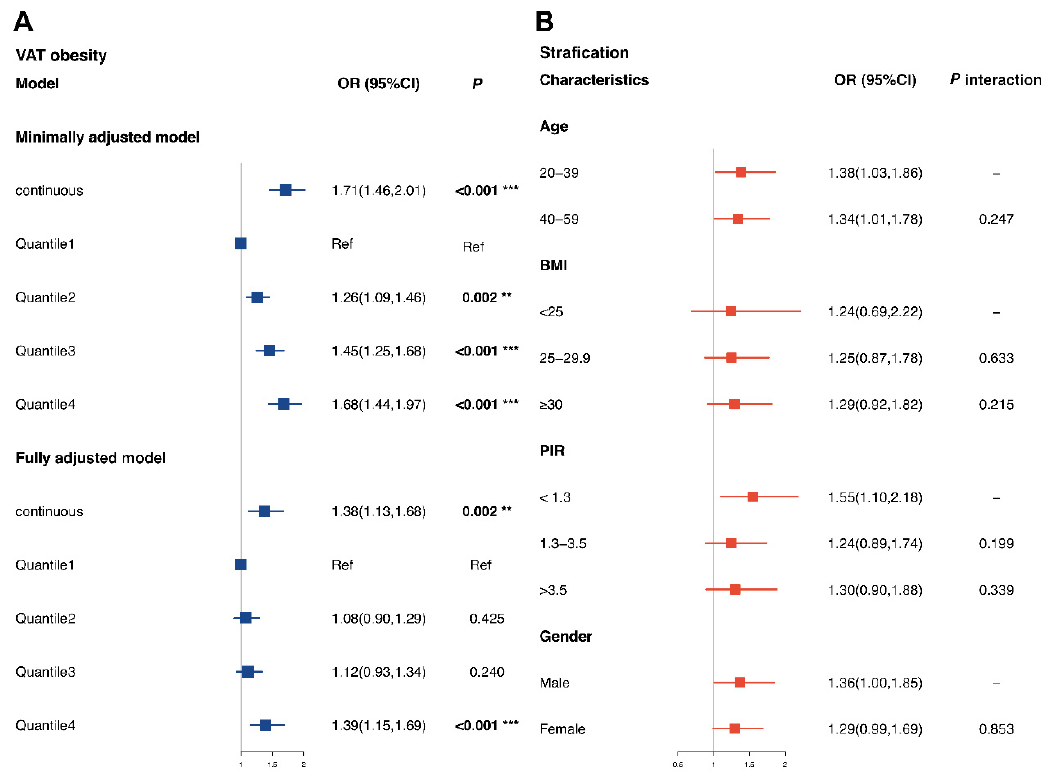
Figure 4. Associations between blood Mn levels and visceral obesity risk. ( A ). Associations be- tween blood Mn levels and visceral obesity in total subjects. Minimally adjusted models were adjusted for gender (only in total), age and race. Fully adjusted models were adjusted for gender, age, race, educational level, BMI, marital status, PIR, smoking status, 24-h alcohol consumption, physical activities, 24-h energy intake, 24-h fat intake. ( B ). Stratified associations between blood Mn levels and visceral obesity. **: p value < 0.01, ***: p value < 0.001.